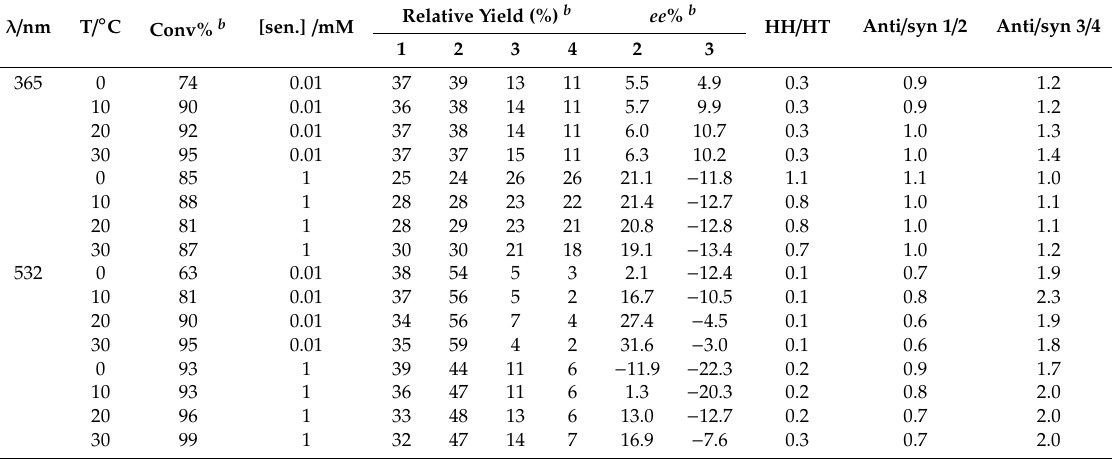
Figure 3. ( a ) Isothermal titration calorimeter (ITC) data for Pt-3 (2 mM) and AC (0.2 mM) in 25 mM borate buffer (pH 9.0) at 0 °C. The top is the raw data for power versus time, and the bottom is the integrated enthalpy values versus the molar ratio of Pt-3 : AC = 1:2, and obtained K 1 as 3810 M − 1 , K 2 as 5350 M − 1 . ( b ) Representative temperature-dependence (differential Eyring) plots obtained in the photoreaction of AC irradiated with 365 nm LED and 0.01 mM Pt-3 ( (cid:4) ) or 1 mM Pt-3 ( (cid:8) ), with 532 nm laser and 0.01 mM Pt-3 ( (cid:78) ) or 1 mM Pt-3 ( (cid:72) ). The top is the ee of 2 , and the bottom is the ee of 3 . Table 4. Photocyclodimerization of AC (0.2 mM) and Pt-3 mediated by temperature a